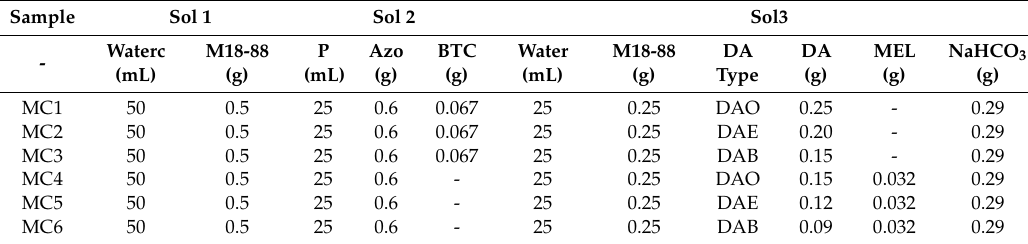
Table 1. Monomers used for the preparation of polyamide microcapsules.